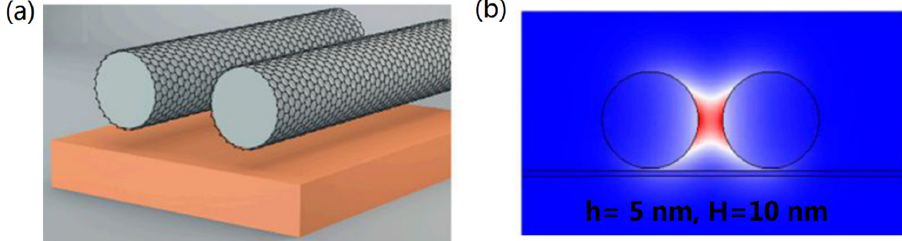
Figure 5. ( a ) Schematic of GCNW pair above a substrate, and ( b ) normalized electric field distribution of the fundamental graphene plasmon mode at 30 THz [69]. of the fundamental graphene plasmon mode at 30 THz